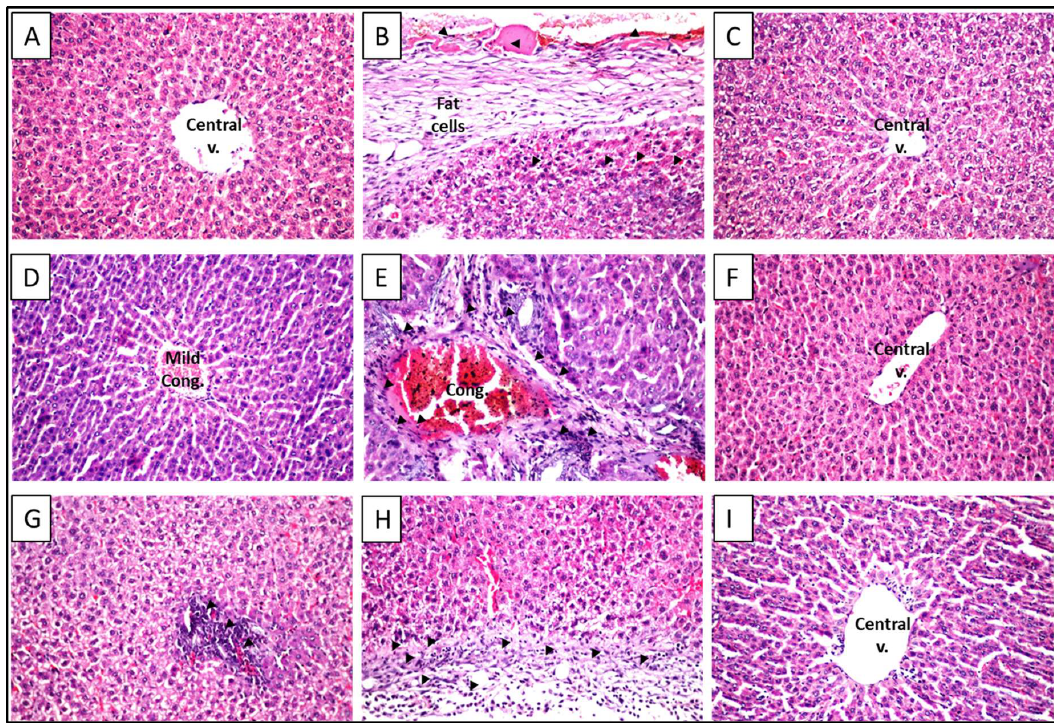
Figure 3. Representative photomicrographs of liver sections stained with ( H & E ) (100×). ( A ) Section taken from a control rat liver showing normal central vein and hepatic architecture; ( B ) Section taken from rat liver exposed to CCl 4 showing thickening and fibrosis with fat cells deposition in the hepatic capsule associated with extended fibrosis to the hepatic parenchyma between the degenerated hepatocytes (arrowhead); ( C ) Section taken from rat liver exposed to CCl 4 and treated with silymarin (100 mg/kg) showing restoration of normal histological structure; ( D ) Section taken from rat liver exposed to CCl 4 and treated with ETN (100 mg/Kg) showing mild congestion in the central vein; ( E ) Section taken from rat liver exposed to CCl 4 and treated with ETN (50 mg/Kg) showing portal vein congestion with inflammatory cells infiltration in the portal area; ( F ) Section taken from rat liver exposed only to ETN (100 mg/Kg) showing no histopathological alterations; ( G ) Section taken from rat liver exposed to CCl 4 and treated with STN (100 mg/Kg) showing focal inflammatory cells infiltration (arrowheads); ( H ) Section taken from rat liver exposed to CCl 4 and treated with STN (50 mg/Kg) showing diffuse inflammatory cells infiltration (arrowheads), with hepatocytes degeneration. ( I ) Section taken from rat liver exposed only to STN (100 mg/Kg) showing normal liver architecture.